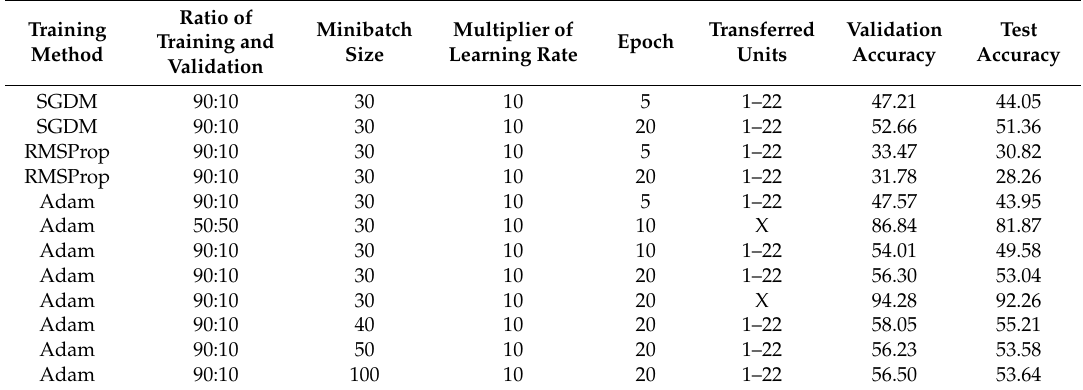
Table 7. Performance of AlexNet on CU-ECG.